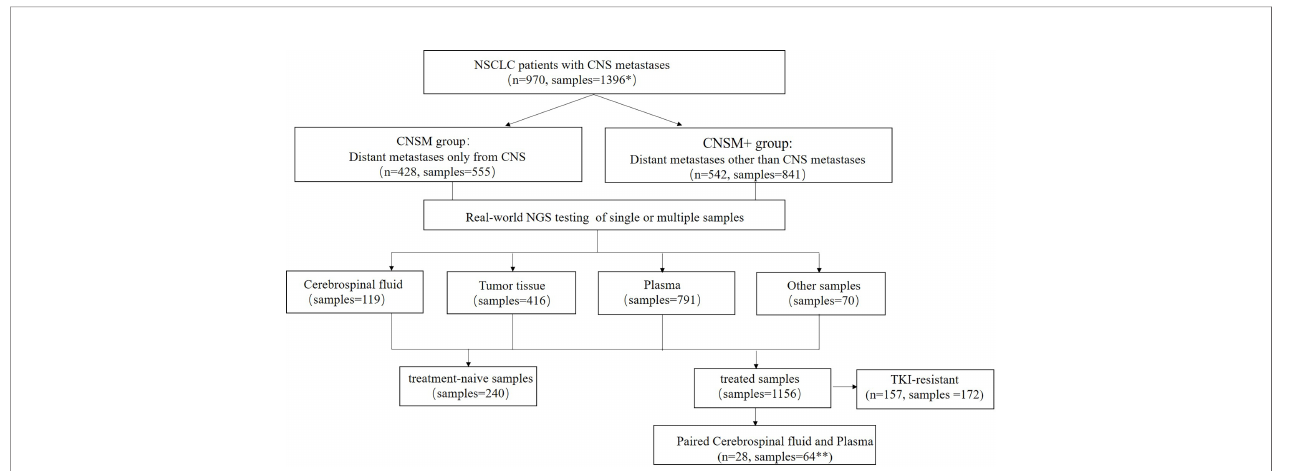
FIGURE 1 | Study design. NSCLC, non-small cell lung cancer; CNS, central nervous system; NGS, Next-generation sequencing. *Among the 970 patients in this study, 688 patients had one sample tested, while 282 patients had multiple samples tested simultaneously or consequently. **Three patients had two or more paired cerebrospinal fl uid and plasma samples. CNSM group, patients who had distant metastases only from the CNS, CNSM+ group, patients with other organ involvement, and distant metastases other than CNS